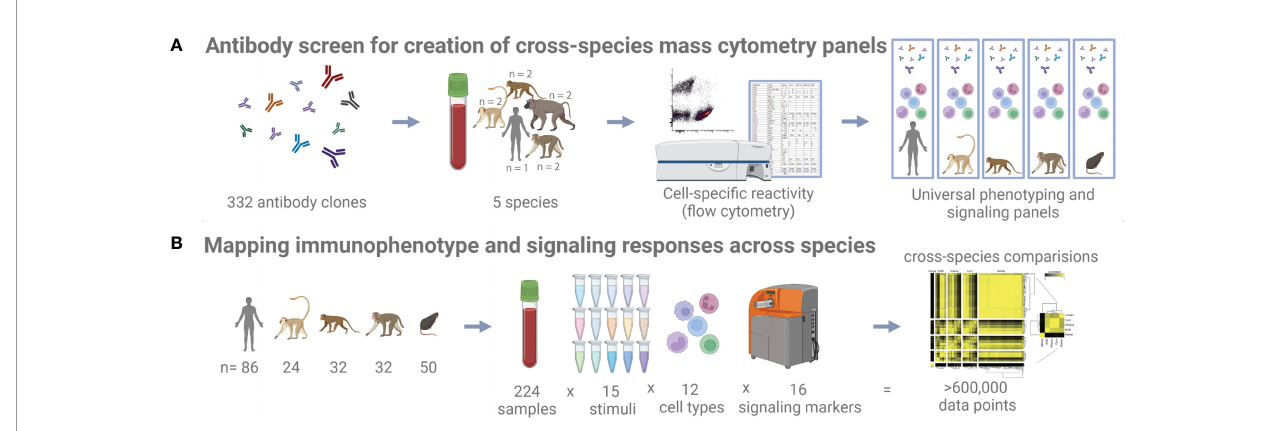
FIGURE 1 | Study schematic. (A) 332 antibody clones were tested on fi ve different species by fl ow cytometry to identify cross-reactive clones. (B) Whole blood samples from fi ve different species and subjected to 15 different stimuli were pro fi led with a universal mass cytometry antibody panel capable of identifying 12 different cell